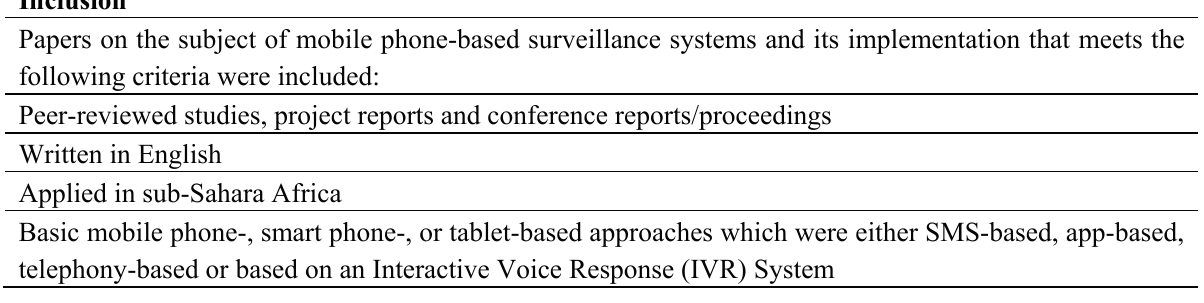
Table 1. Inclusion and exclusion criteria for identified